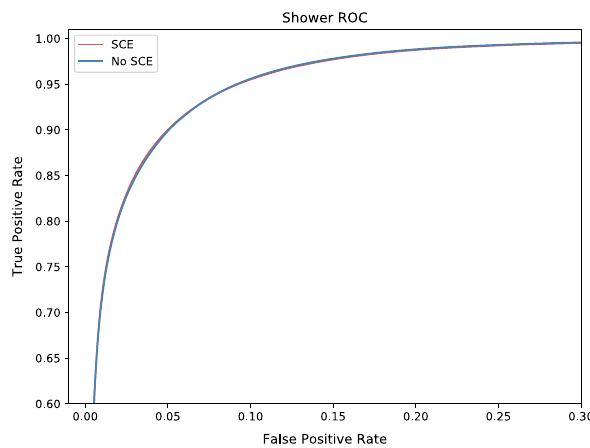
Fig. 6 ROC curves for the shower classifier, showing the true positive rate against false the positive rate for varying classification threshold on the shower classifier output. The red (blue) line shows the ROC curve from ProtoDUNE-SP simulation with (without) SCE. The red curve is obscured by the blue due to close agreement